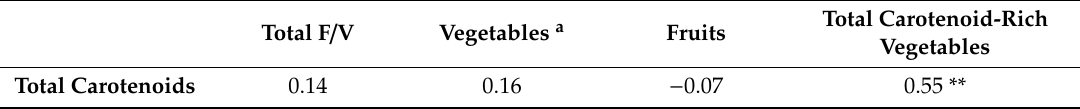
Total Carotenoid-Rich Vegetables